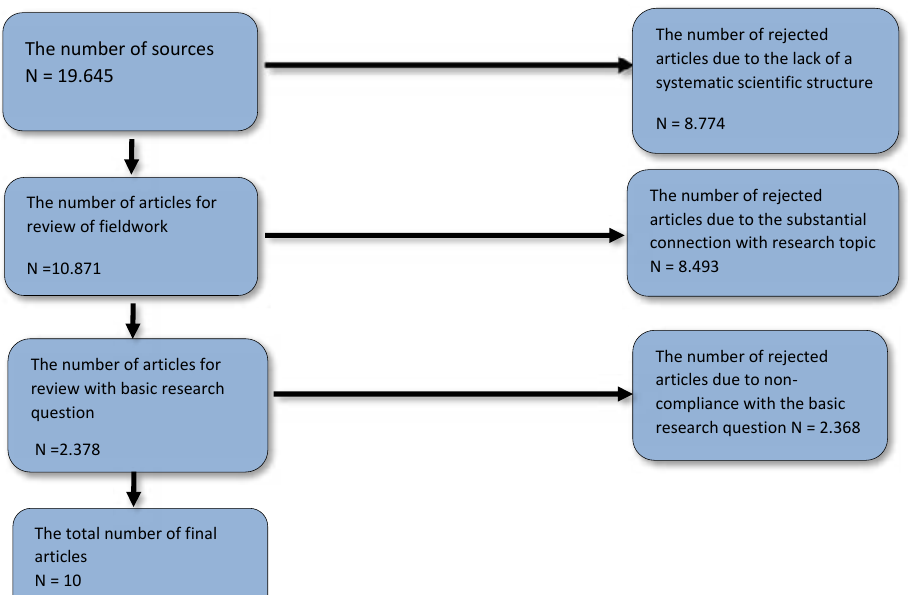
Fig. 2: A diagram of the meta-synthesis steps for the main research question